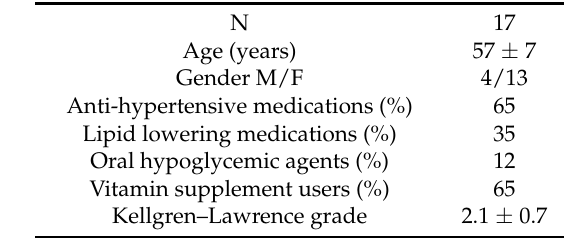
Table 3. Baseline associations of knee pain scores and Health Assessment Questionnaire-Disability Index with selected markers of inflammation and cartilage degradation in obese adults with symptomatic knee osteoarthritis (linear regression coefficients) ( n = 17).